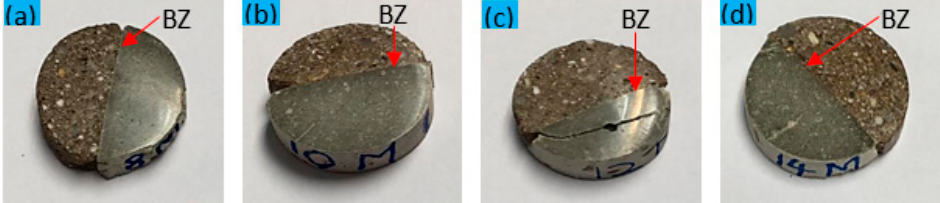
Figure 3. The bonding zone (BZ) between the FA-based geopolymer specimens and OPC substrate at: ( a ) 8 M, ( b ) 10 M, ( c ) 12 M and ( d ) 14 M.